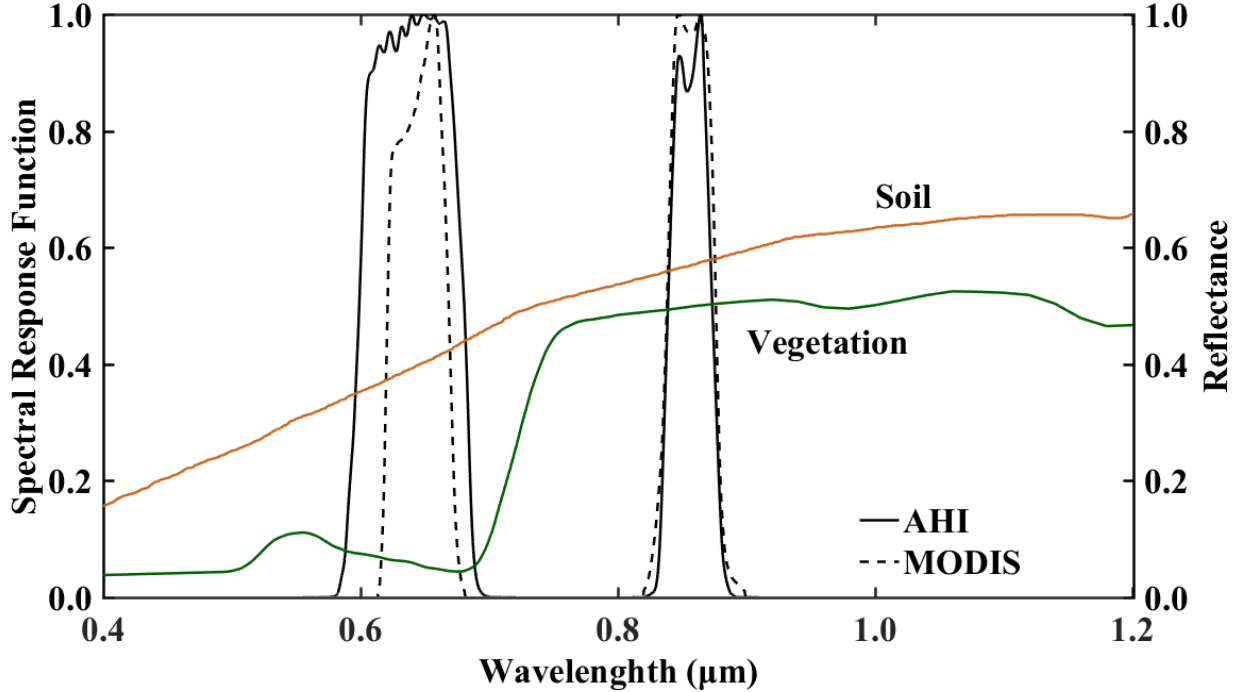
Figure 1. Spectrum response function for red and near-infrared bands of the AHI onboard Himawari-8 satellite and the MODIS on board AQUA satellite.